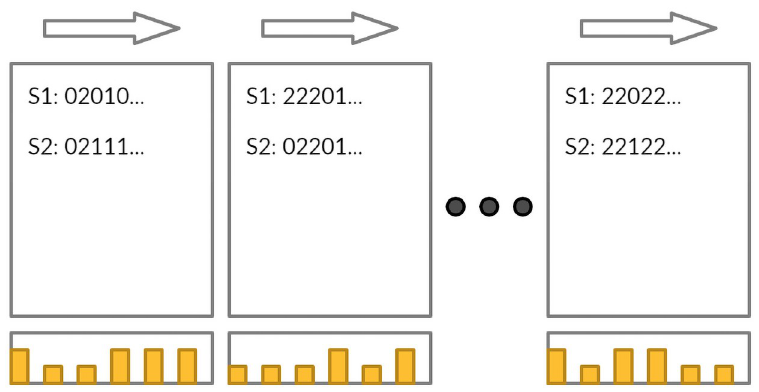
Fig 2. The iterative scheme of our XGBoost selection algorithm. Yellow bars are individual SNP importances for each window. S1, S2 are individual samples. F n is the n ’th XGBoost model, using the respective window of features. F n model is fitted on predictions from model F n − 1